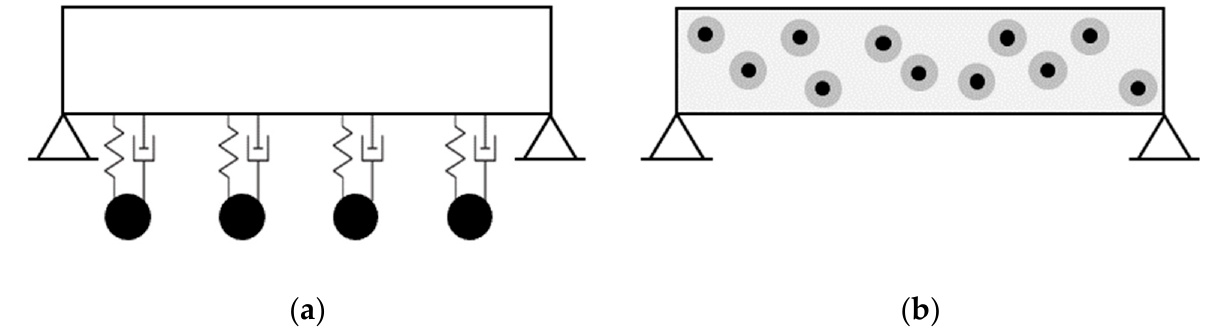
Figure 2. A single-span beam in a multi-TMD setup. ( a ) multiple TMDs distributed across the span. ( b ) distributed core-coating inclusions in concrete forming a multi-TMD setup.